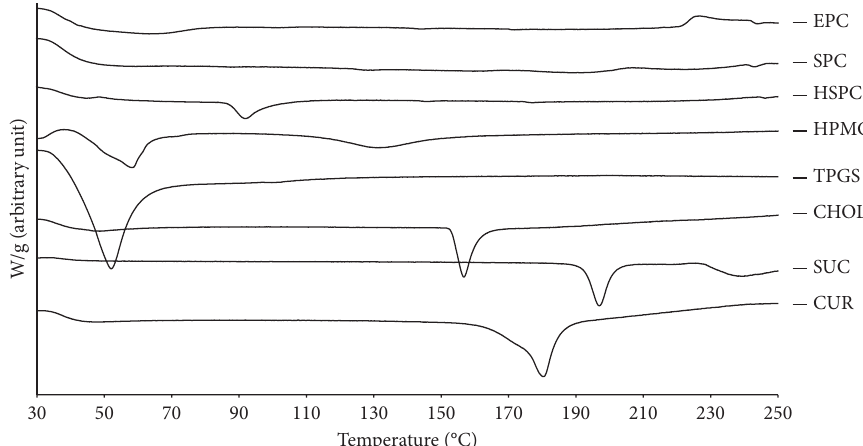
Figure 4: DTA thermograms of all single components used in the developed CUR-loaded liposomal solid gels. Samples were scanned within a range of 30 to 250 ° C, at heating rate of 10 ° C/min. CUR, curcumin; SUC, sucrose; CHOL, cholesterol; TPGS, D- α -tocopheryl polyethylene glycol 1000 succinate; HPMC, hydroxypropyl methylcellulose; HSPC, hydrogenated-soy phosphatidylcholine; SPC, soy-phosphatidyl- choline; EPC,